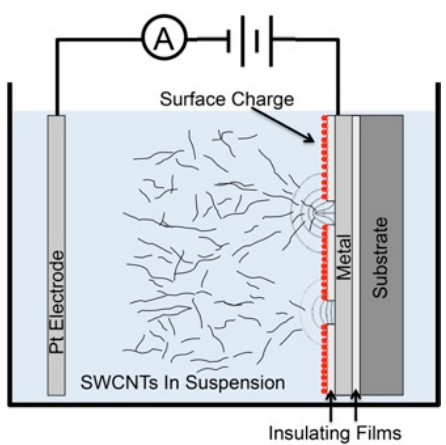
Figure 1. Schematic of electrophoretic deposition (EPD) of carbon nanotubes on metal at the base of nanoscale windows.